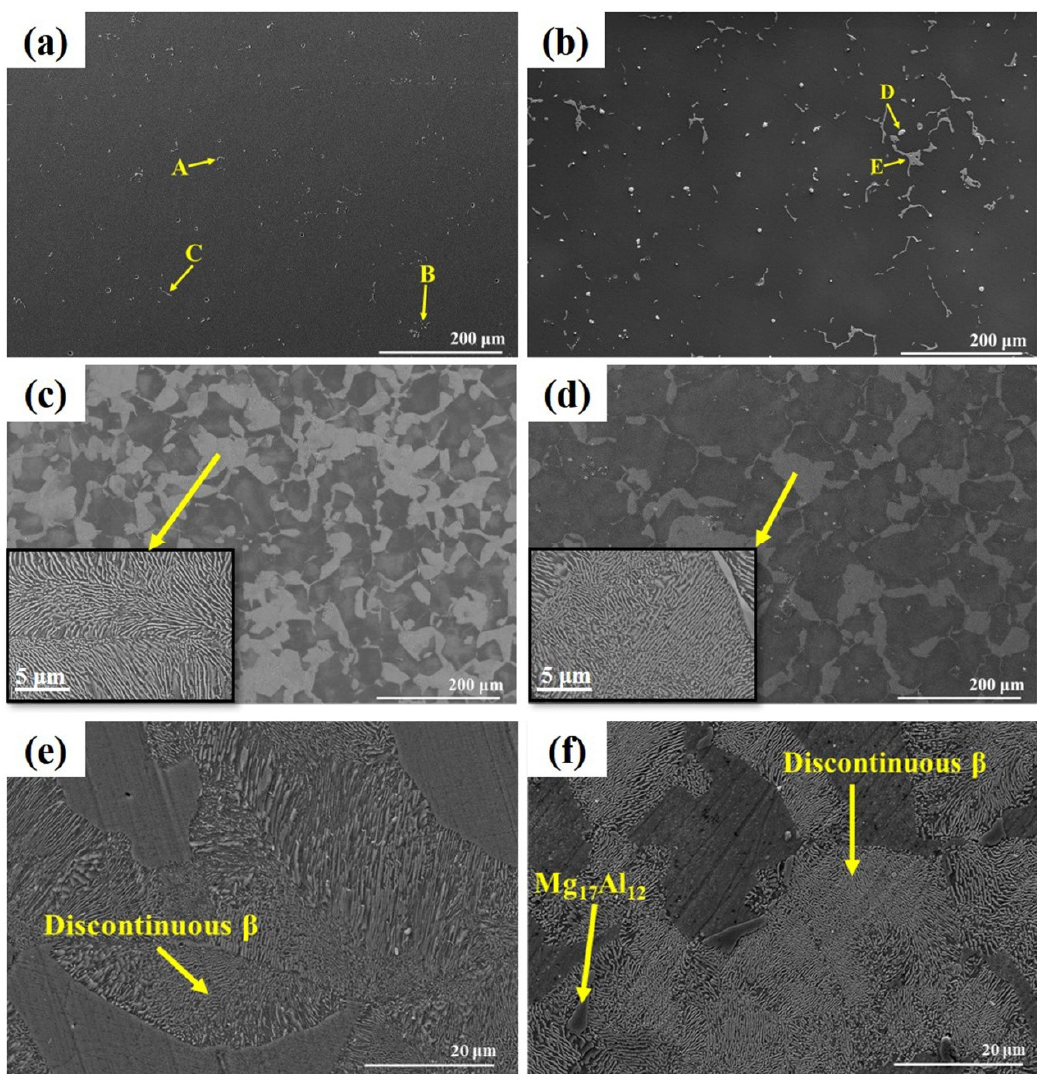
Figure 2. SEM photos and EDS analysis results of AZ91 and AZ91-CaO alloy under different states: